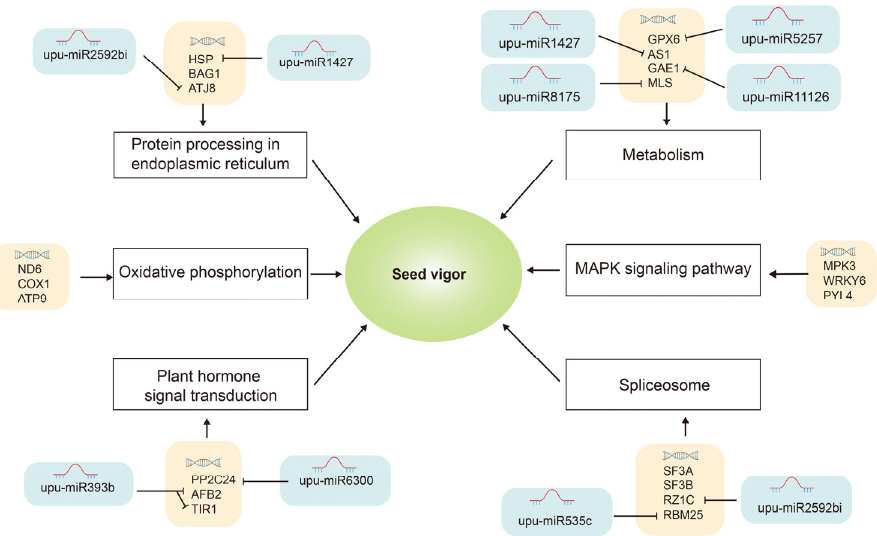
Figure 7. A model for the mRNA and miRNA − mediated mechanism of seed vigor during